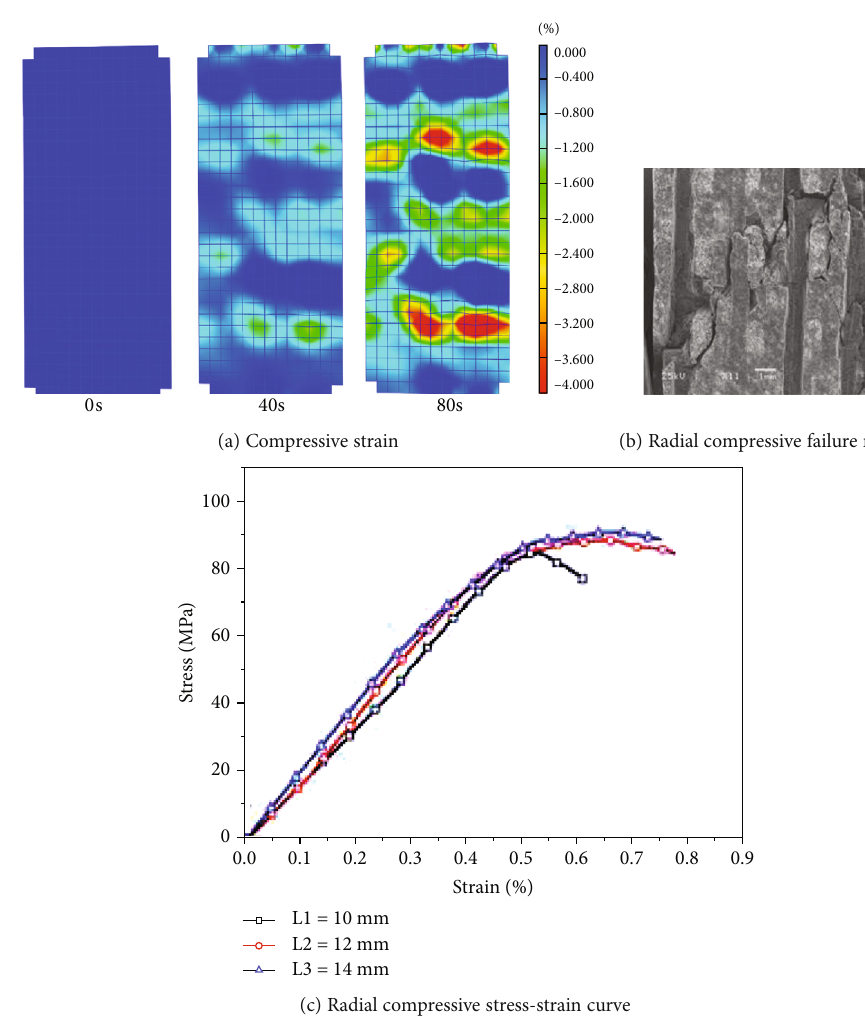
Figure 9: Radial compression test